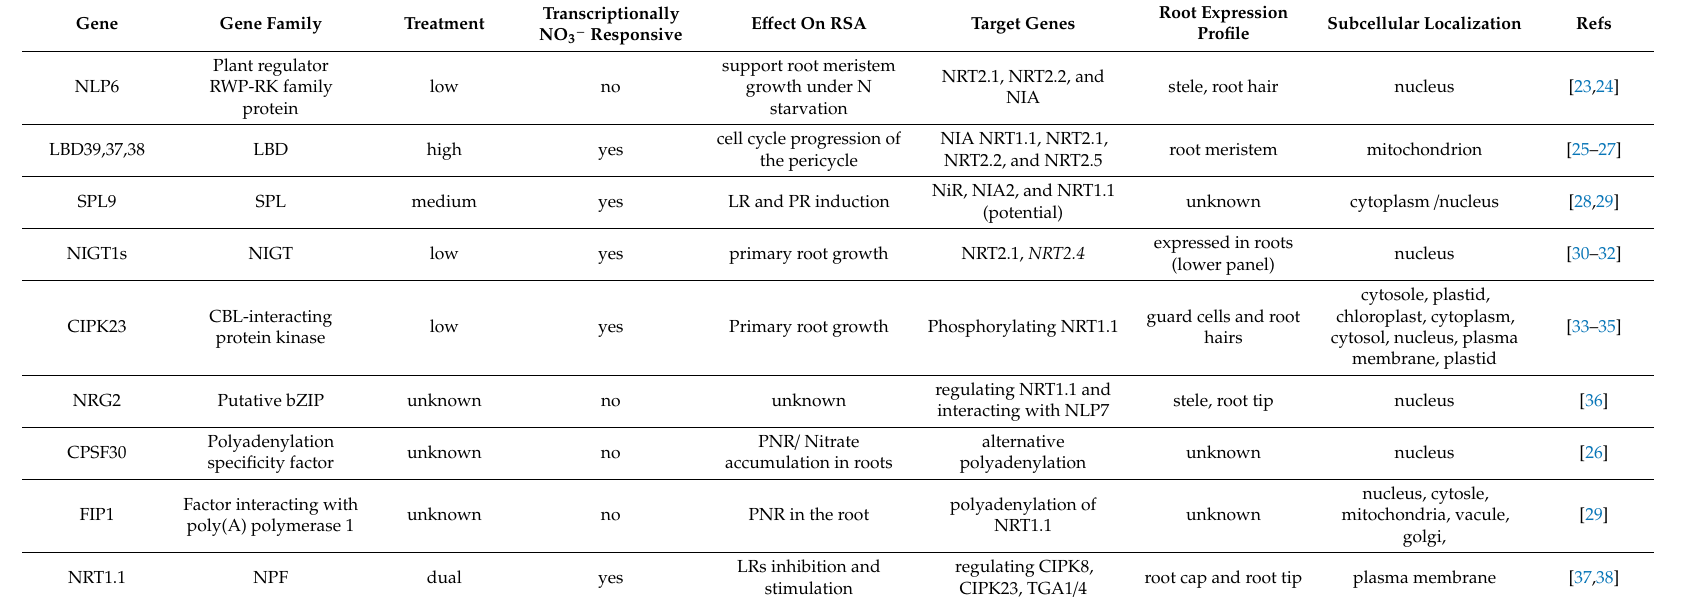
Table 1. Short Term Primary Nitrate Responsive Genes.